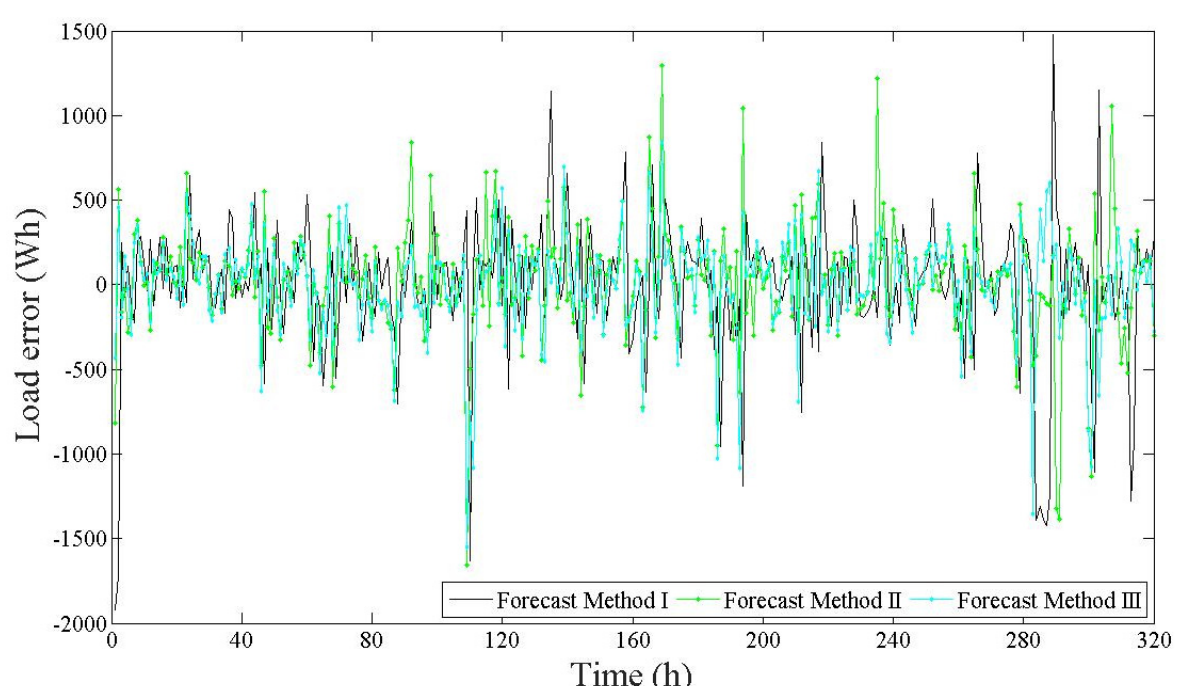
Figure 6. Training error for forecast hourly load of working days of household No 71.